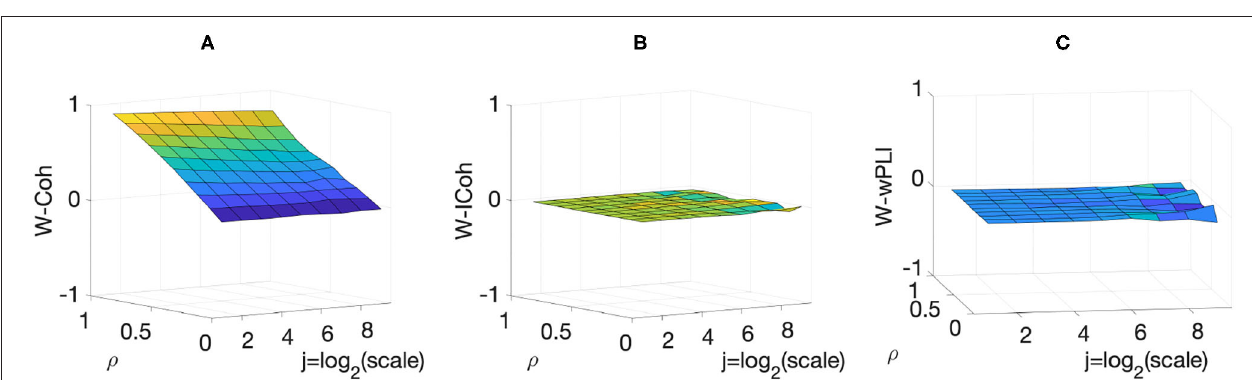
FIGURE 1 | Fourier vs. wavelet spectral estimation on actual source-reconstructed MEG time series. Top: Two source-reconstructed MEG time series X 1 (A) and X 2 (B) . Middle: Wavelet spectra (C,F) , cross spectrum (D) , and coherence function (E) as functions of the (log of the) scales (top row, red lines). Bottom: Comparison to Fourier spectra (G,J) , cross-spectrum (H) , and coherence function (I) (solid black lines) after remapping scales into frequencies (bottom row). The scale-free (or arrhythmic) regime is marked by linear behaviors of the power spectra across coarse scales, 8 ≤ j ≤ 12 corresponding to low frequencies, 0.1 ≤ f ≤ 1.5 Hz, in these log log plots.